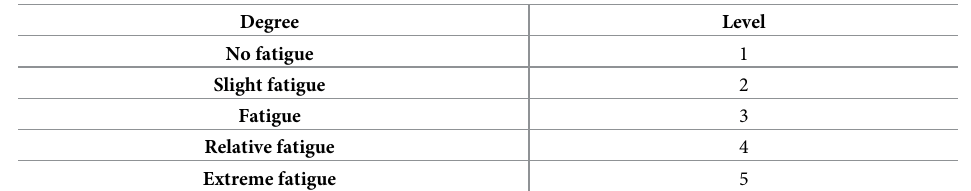
Table 6. Fatigue grading and